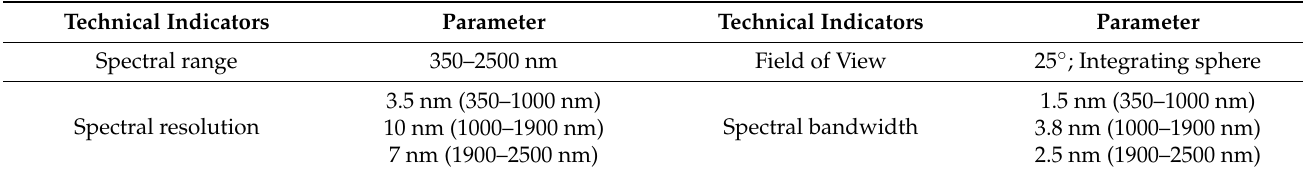
Table 3. Technical parameters of SR-3500 portable full-spectrum ground object spectrometer.